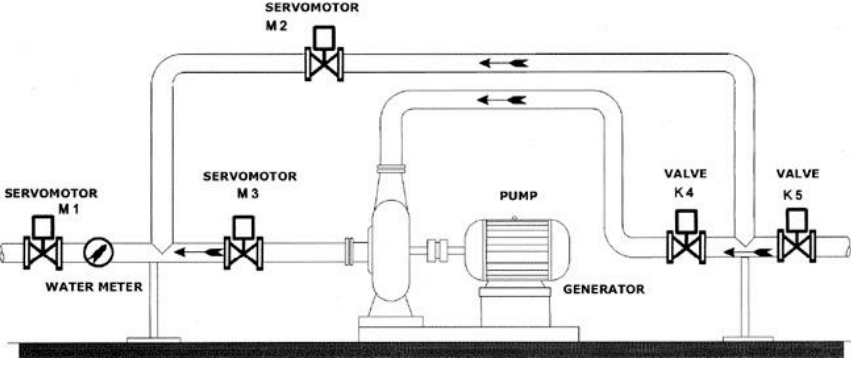
Figure 4. SHPP machine set [40].